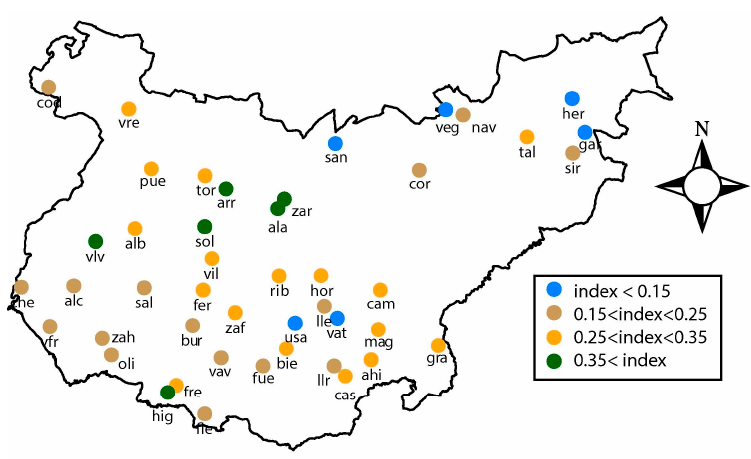
Figure 5. Load Index for each one of the plants studied. Table 7. Summary of Load Index .